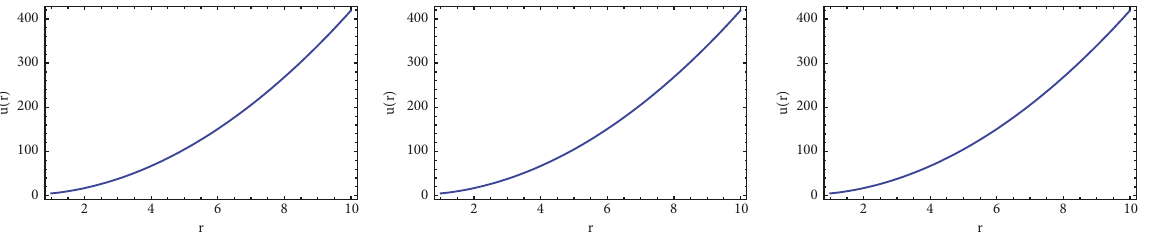
Figure 20: This figure represents the variation of 𝑢(𝑟) versus 𝑟 (km) for the strange star taking 𝛽 = 1 , 𝛽 = 2 , and 𝛽 = 3